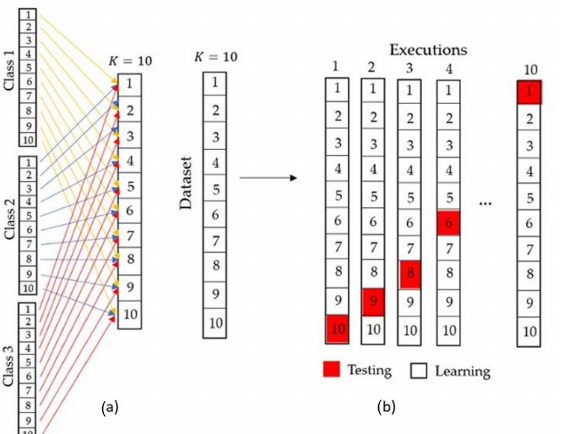
Figure 1. ( a ) The 10-fold stratified cross validation method. A data set is divided into three classes and located into 10 folds. ( b ) Operation of the 10-fold stratified cross validation method. The process consists of performing 10 iterations; in the first iteration, the classifier learns with the first 9 folds and the last is used for testing; the second leaves fold 9 to test and learn with the remaining folds and so forth.